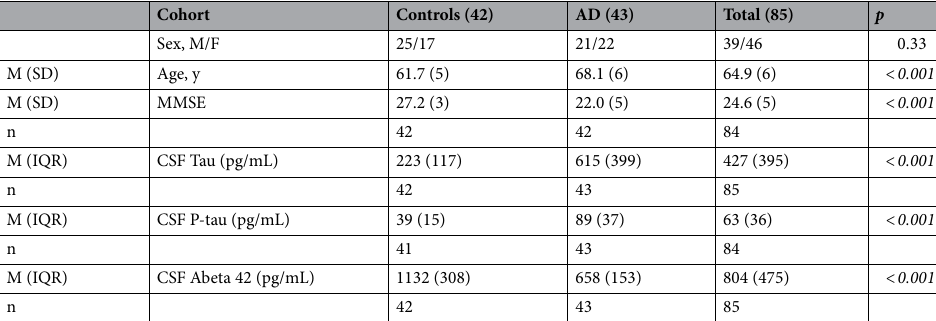
Table 1. Cohort characteristics and biomarker values in the clinical validation. Abeta, Amyloid beta; CSF, Cerebrospinal fluid; ELISA, Enzyme-Linked Immuno Sorbent Assay; MMSE, Mini-Mental State Examination; pTau, phosphorylated tau. M (SD) shows the mean value and standard deviation. M (IQR) shows the median value and interquartile range. P values show the difference between the CSF Aβ negative and the CSF Aβ positive group. Significant p-values are shown in italics ( p <